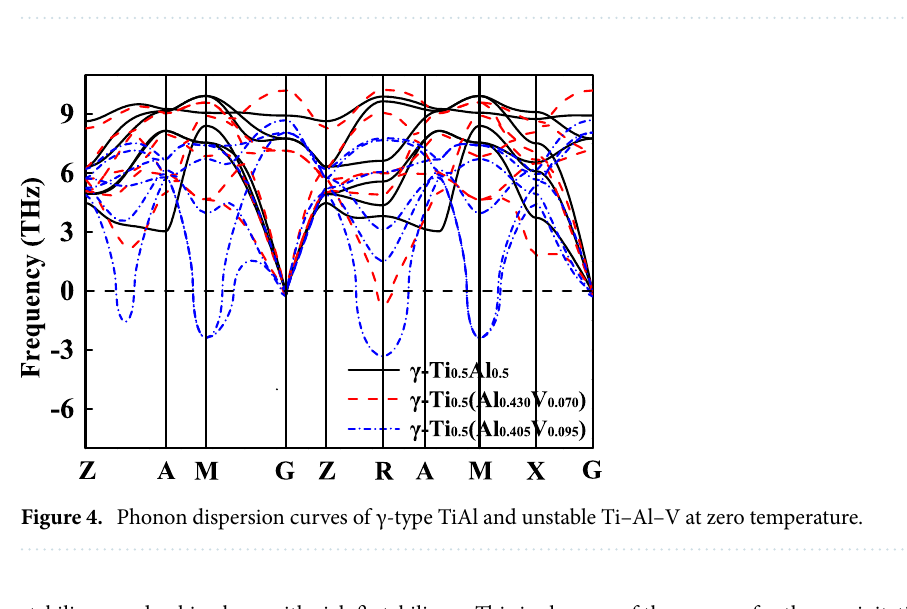
Figure 3. Composition dependent phonon dispersion curves of β 0 -type Ti–Al–V at zero temperature.